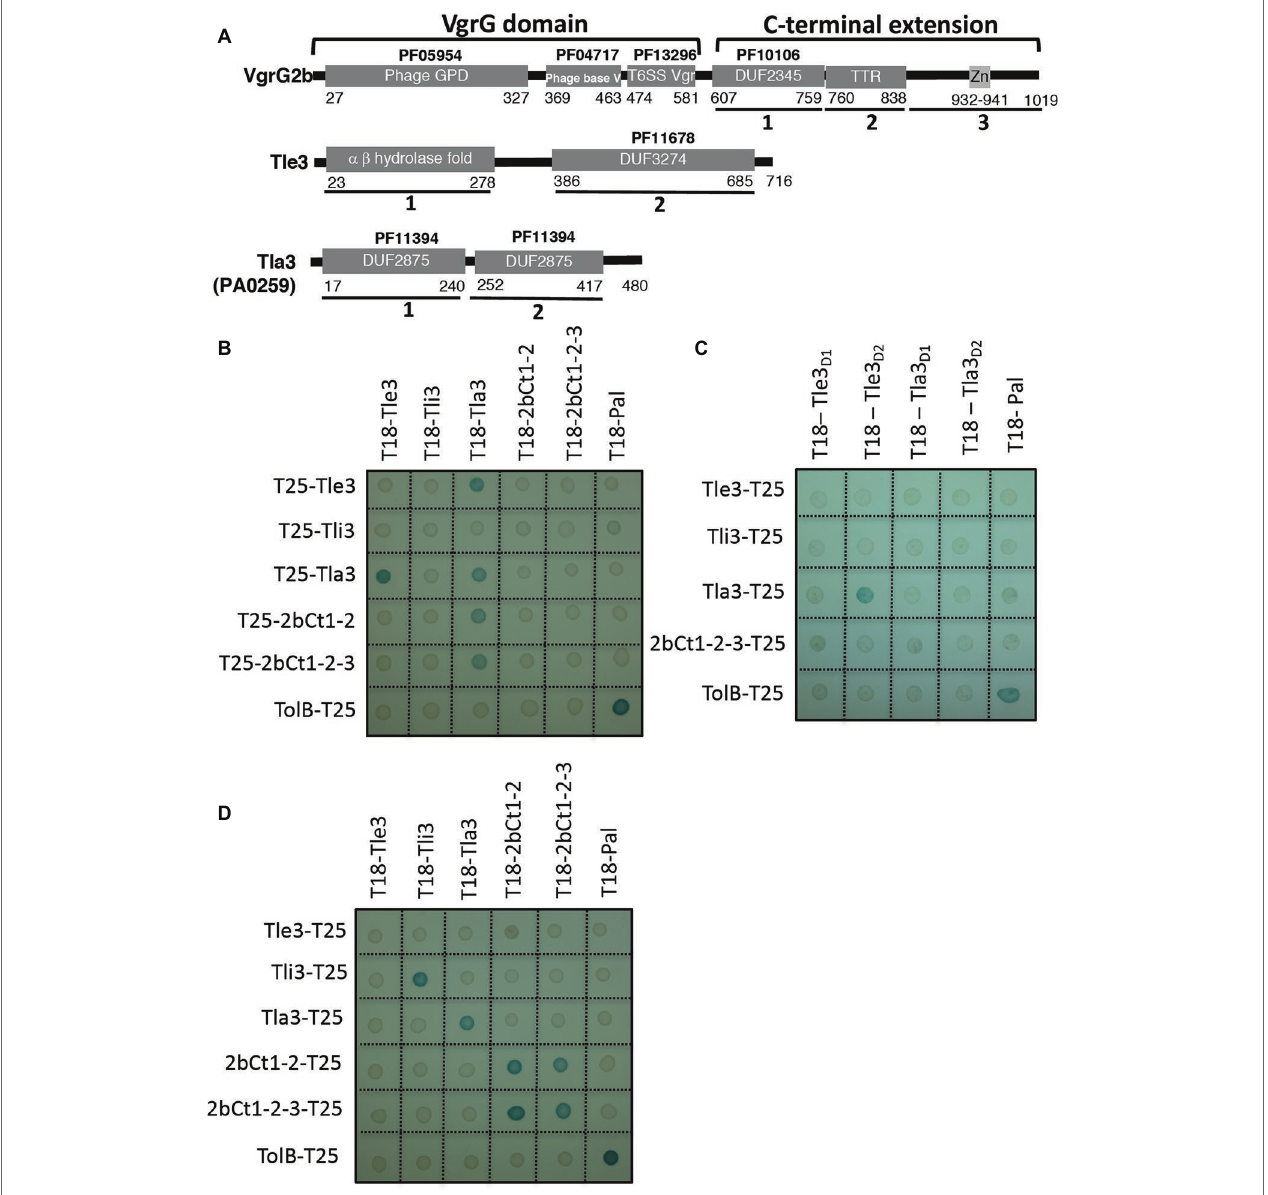
FIGURE 3 | (A) Tla3 (PA0259) interacts with the Tle3 toxin and with VgrG2b. Domain organization of VgrG2b, Tle3, and Tla3 (PA0259). The first 581 residues of VgrG2b carry the VgrG domain homologous to gp27 and gp5 phage tail proteins and consisting of three sub-domains. This is followed by the C-terminal extension, composed of a conserved domain of uncharacterized proteins (DUF2345, PF10106) (2bCt1), a TTR (transthyretin-like region) (2bCt2), and a putative zinc-dependent metallopeptidase pattern (LFIHEMTHVW signature, PS00142) (2bCt3). Tle3 architecture consists of an α , β hydrolase fold domain (Tle3 D1 ) followed by a DUF3274 (Tle3 D2 ), Tla3 of a tandem of DUF2875 (Tla3 D1 and Tla3 D2 ). (B–D) Bacterial two-hybrid assay. BTH101 reporter cells producing the indicated proteins or domains fused to the T18 or T25 domain of the Bordetella adenylate cyclase were spotted on X-gal indicator plates. The blue color of the colony reflects the interaction between the two proteins. TolB and Pal are two proteins known to interact but unrelated to the T6SS. The experiment was performed in triplicate and a representative result is